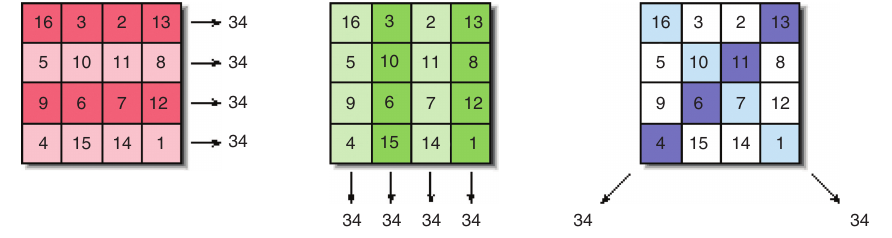
Figure 1: A Basic 4 × 4 Magic